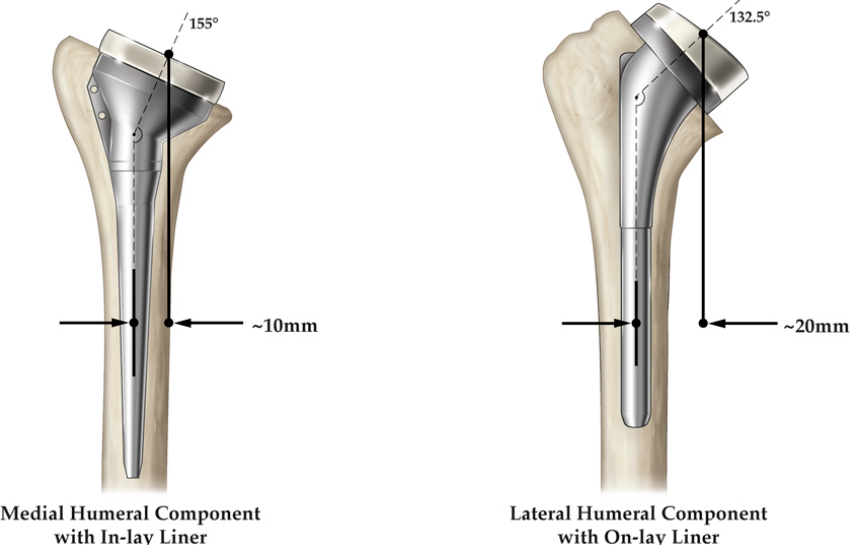
Figure 7. rTSA humeral prosthesis design classification, examples of a medial humeral component with an inlay humeral liner ( left ) and a lateral humeral component with an onlay humeral liner ( right ).